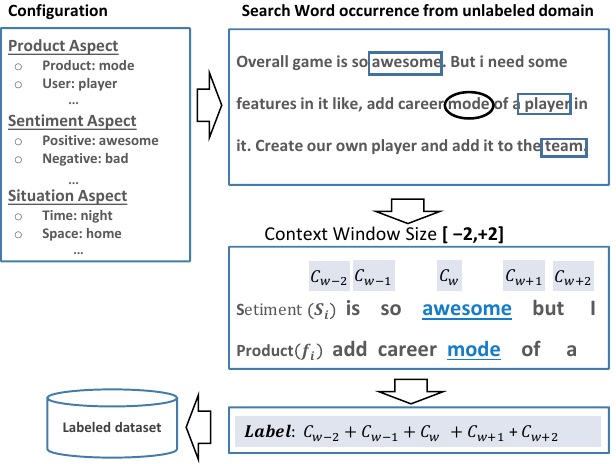
Figure 5. Auto labeling process based on the context